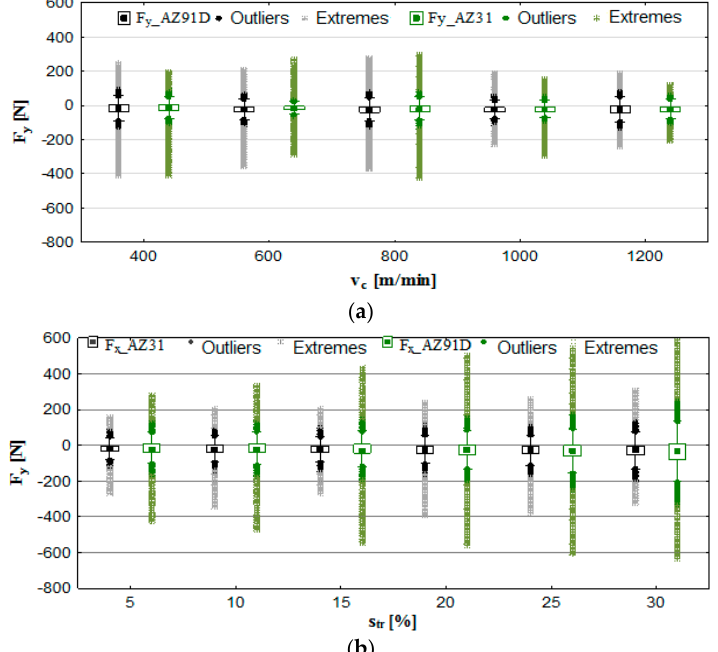
Figure 6. Effect of cutting speed and trochoidal step on cutting force component F y in milling of magnesium alloys: ( a ) v c (f z = 0.15 mm/tooth, a p = 6 mm, s tr = 15%) and ( b ) s tr (v c = 800 m/min, f z = 0.15 mm/tooth, a p = 6 mm).